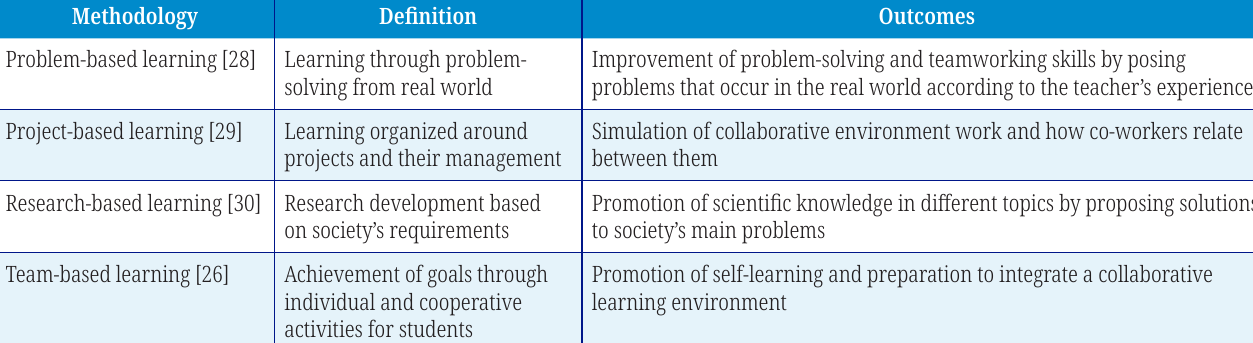
Table 1. Selected learning-centered